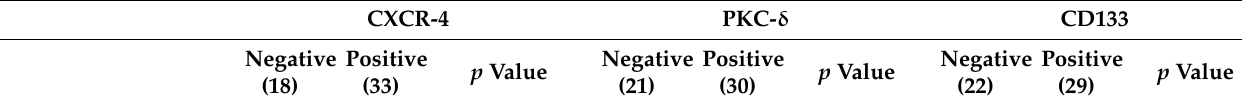
Table 2. Association between CXCR4, PKC- δ and CD133 and clinicopathological